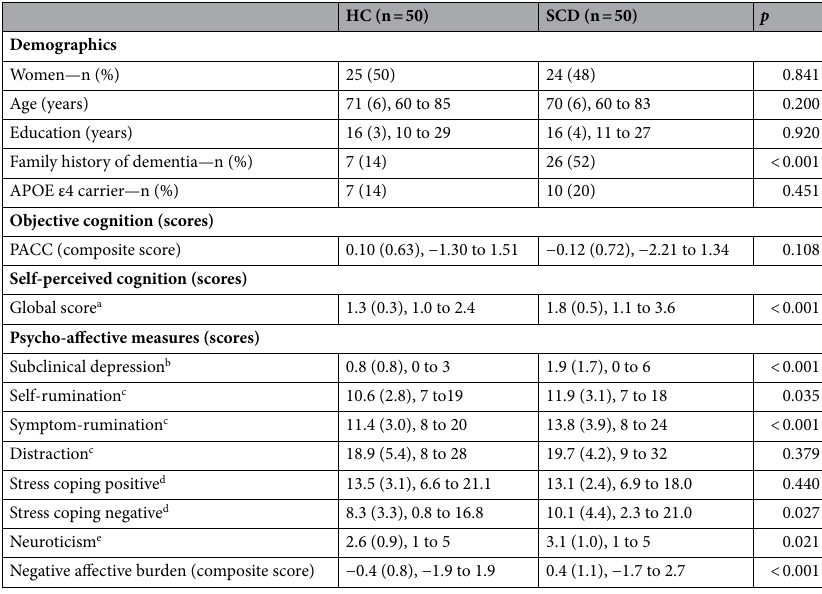
Table 2. Demographics and sample characteristics. If applicable, measures are expressed as mean (standard deviation) and range. APOE ε4 carrier status of one participant of the healthy controls (HC) group is missing.